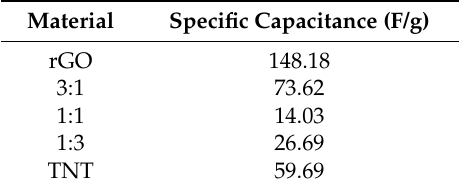
Table 1. Specific capacitance of GO/TNT composites at 5 mV/s.